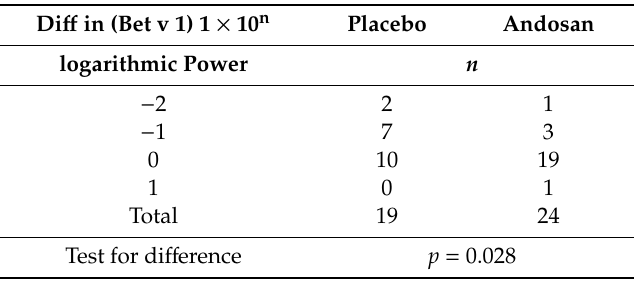
Table 5. Shift in maximal Bet v 1 concentration needed for basophil activation from before until after